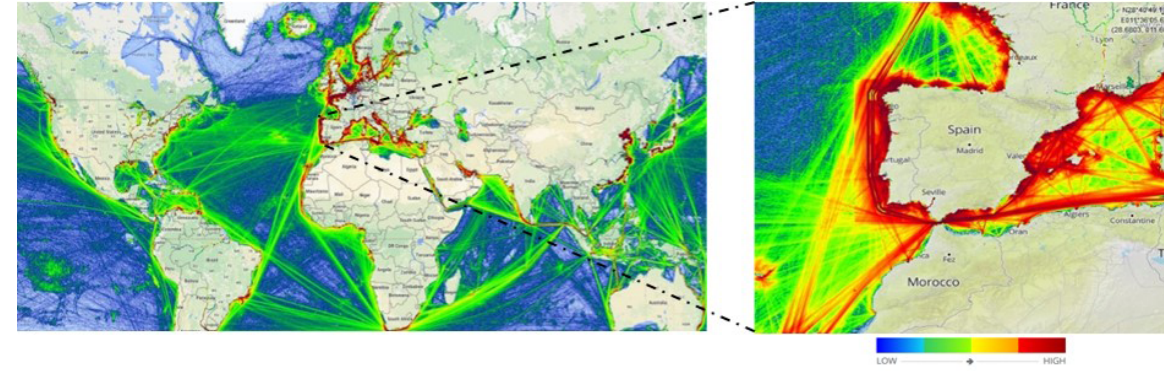
Figure A1. World shipping traffic density map and a zoom of the study area for 2015 (source: Marine Traffic, 2016).